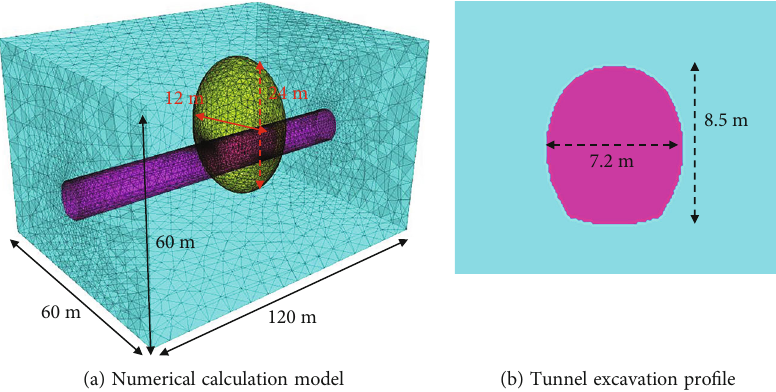
Figure 2: Numerical calculation